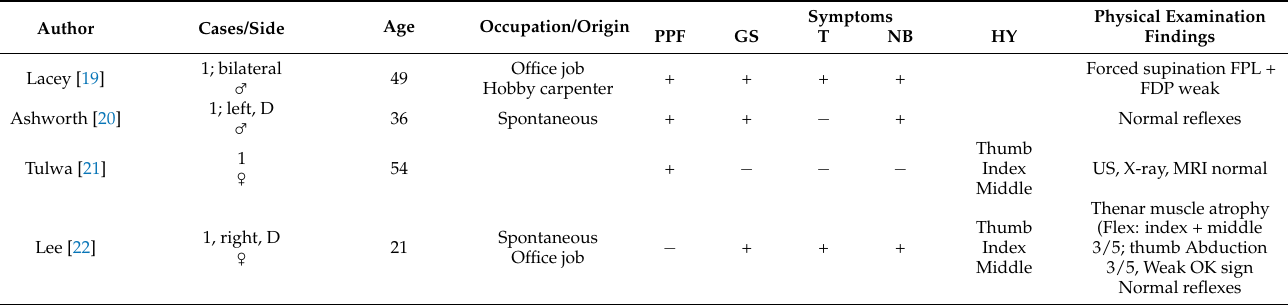
Table 4. Overview of clinical studies—literature